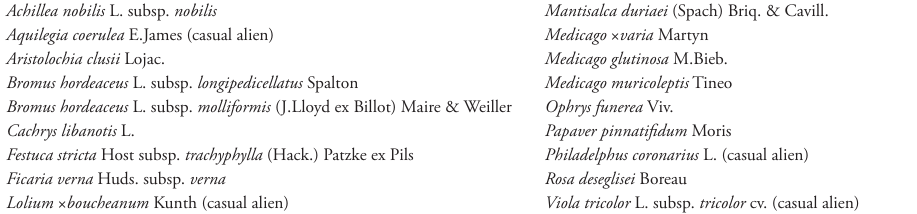
Table 2. List of taxa new for Campania. Achillea nobilis L. subsp. nobilis